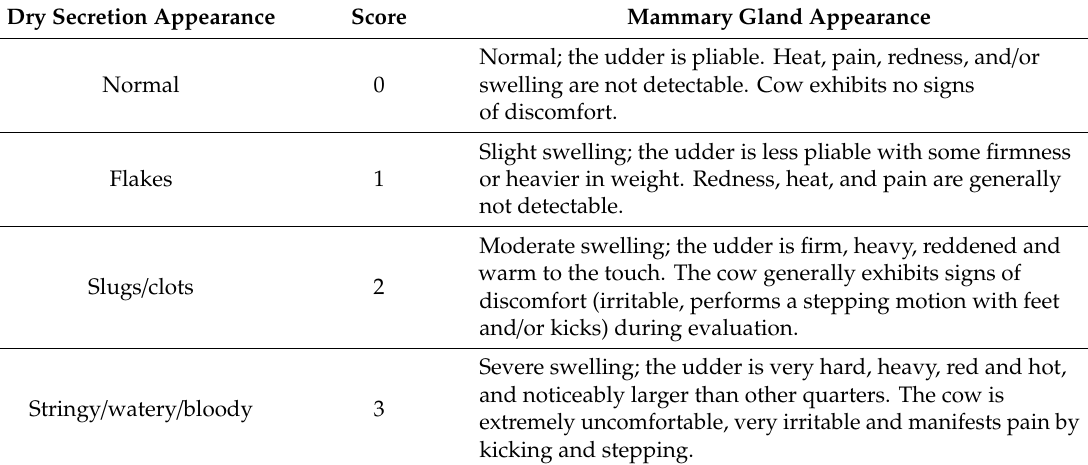
Table 2. Inflammatory changes in dry secretion and mammary gland tissue scoring scheme.